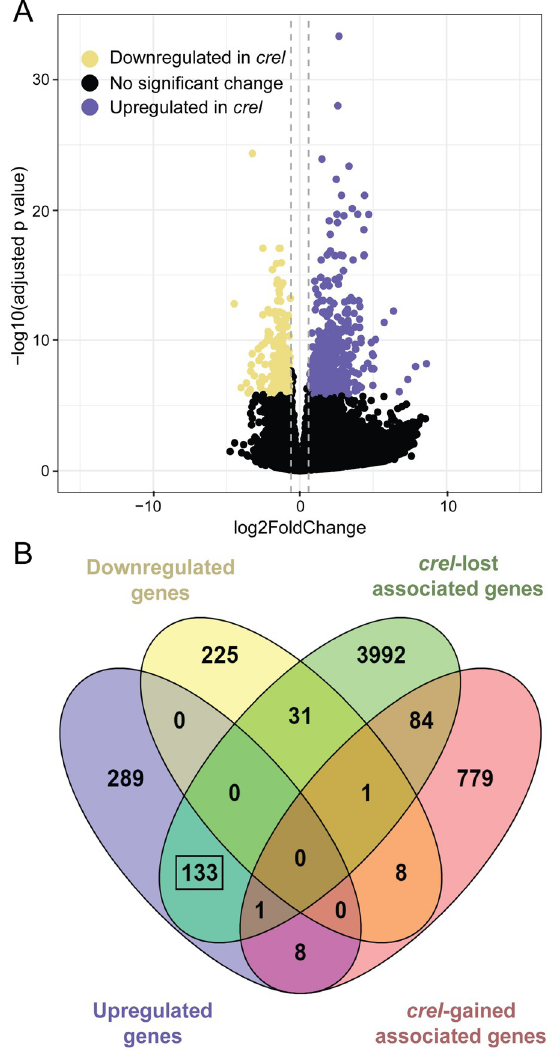
Fig 8. Changes in H3K27me3 deposition in crel mutant plants correlate to gene expression changes as measured by RNA-Seq. (A) Differential gene expression analysis of WT and crel shoot apices by RNA-seq. These data are illustrated in a volcano plot, with purple dots representing upregulated transcripts (adjusted p value < Bonferroni corrected significance threshold of 1.4e-6 and log2 fold change > 0.6) and yellow dots representing downregulated transcripts (adjusted p value < 1.4e-6 and log2 fold change < -0.6). Vertical dashed lines delineate log2 fold change thresholds of -0.6 and +0.6. Four hundred and thirty one (431) transcripts were significantly upregulated and 265 were significantly downregulated in crel plants compared to WT. (B) Venn diagram comparing the overlap of upregulated transcripts (purple) and downregulated transcripts (yellow) to genes associated with H3K27me3 peaks unique to WT ( crel- lost sites; green) and unique to crel-2 ( crel- gained sites; green). The black box highlights overlap between upregulated transcripts and genes associated with WT unique peaks ( crel- lost sites).